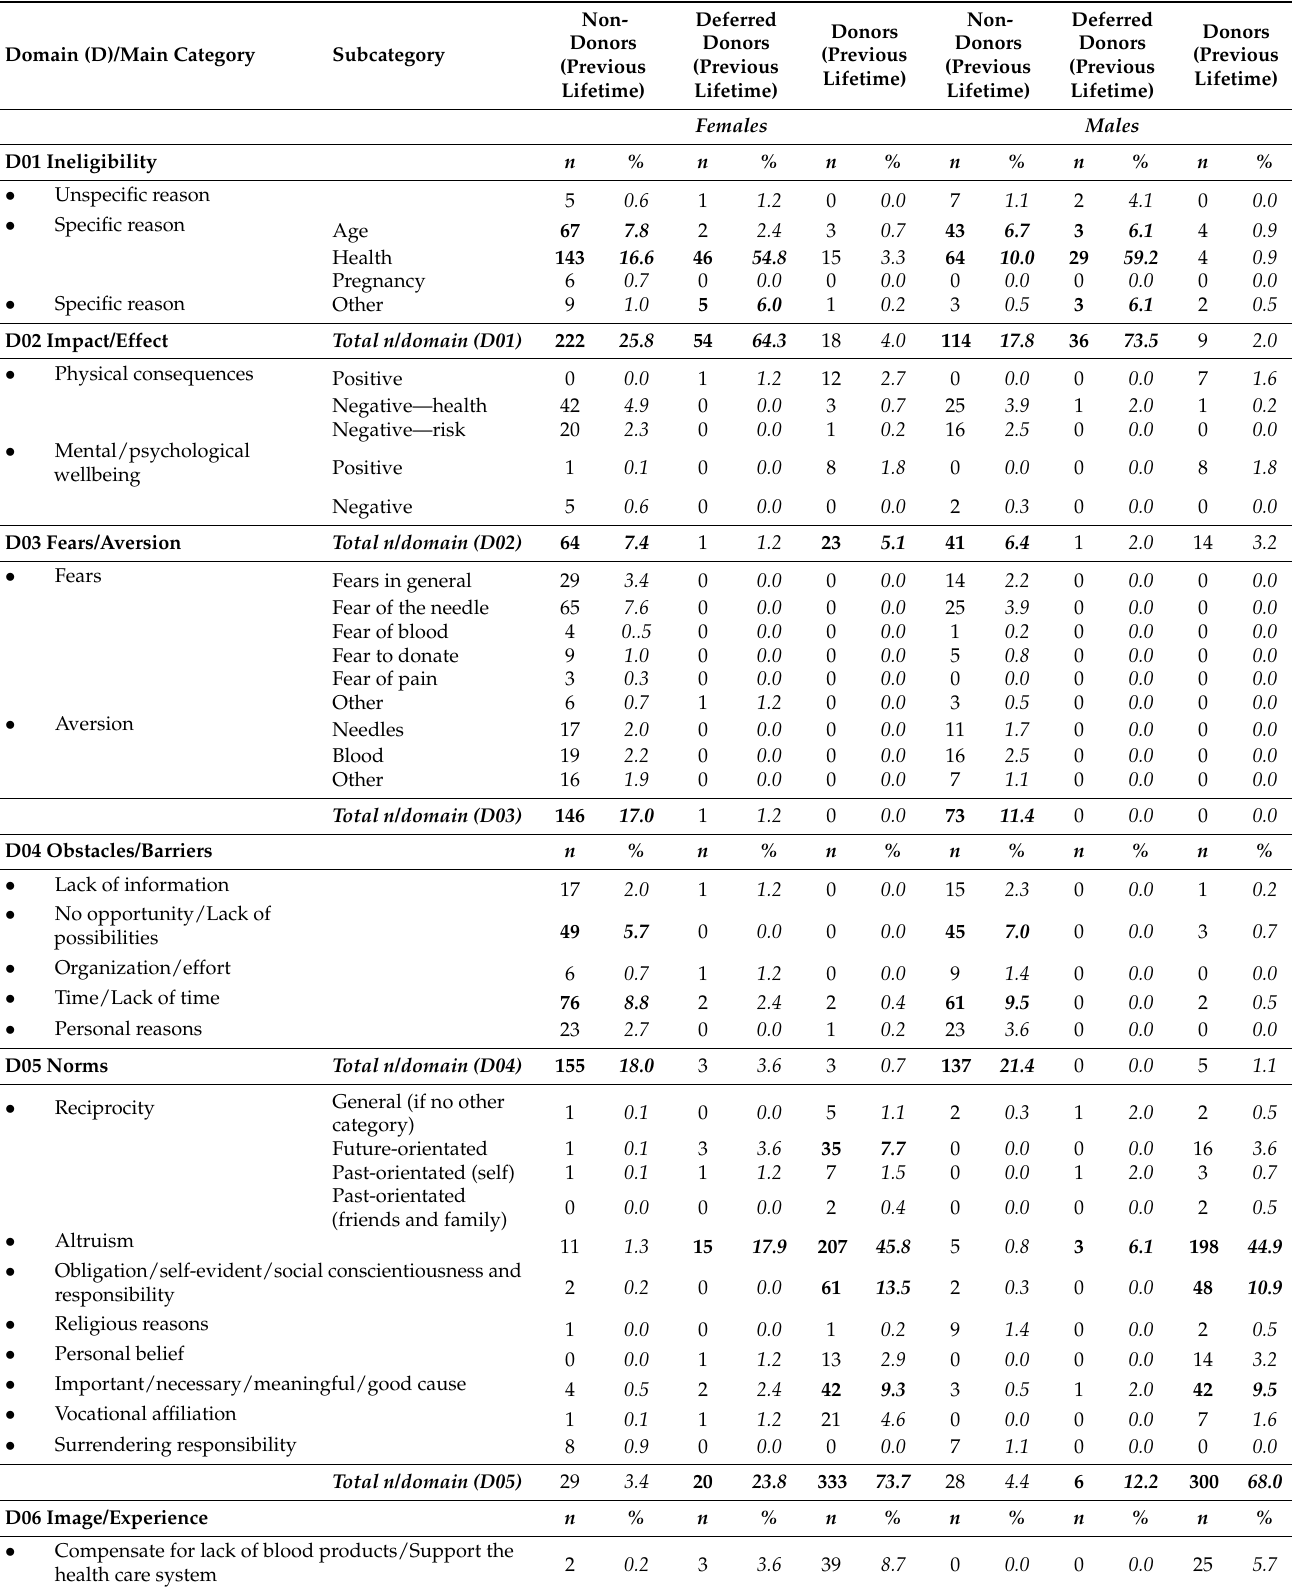
Table A4. Self-reported motivators and deterrents for retrospective (lifetime) blood donation behaviour—results for different donor types and separated for sex ( n = 2531, unweighted)